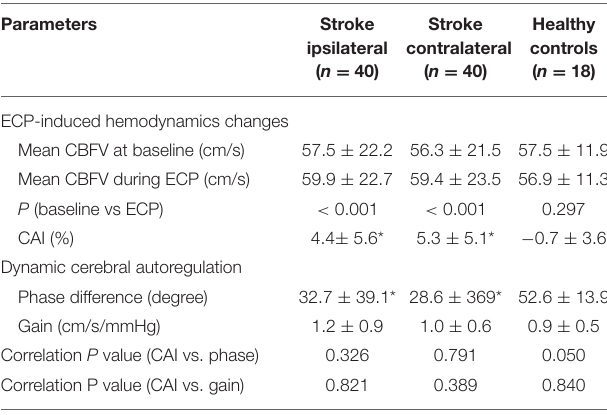
TABLE 2 | Cerebral augmentation effects of ECP and dynamic cerebral